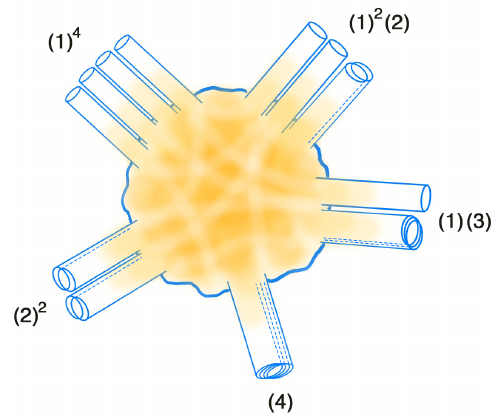
Figure 2. Cartoon of the deformed symmetric orbifold for p = 4 . The coordinate φ increases radially outward from the center of the figure. There are different asymptotic limits φ → ∞ corresponding to the different ways of partitioning long string winding, or equivalently according to the conjugacy classes of the symmetric group S . At finite φ , one loses the symmetric product structure, where 4 the “wall” interconnects the different winding sectors. More precisely, such effects occur at any φ , but their effects are decaying exponentially as φ